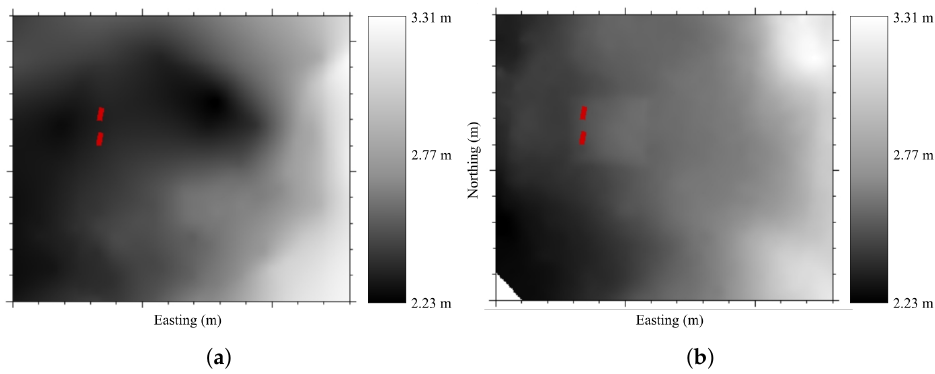
Figure 4. Side-by-side comparison of topographic surfaces used to perform grid-wide topographic corrections on GPR data. ALS elevations ( a ) have 0.3 m lateral resolution and 0.2 m vertical resolution; TLS elevations ( b ) have 0.05 m lateral resolution and subcentimeter vertical resolution. TLS point cloud was georeferenced by anchoring the ground at the cemetery’s fence corners to corresponding elevations from ALS. Thus, TLS elevations are heights relative to those anchor points. ( a ) aerial-LiDAR Elevations. ( b ) TLS